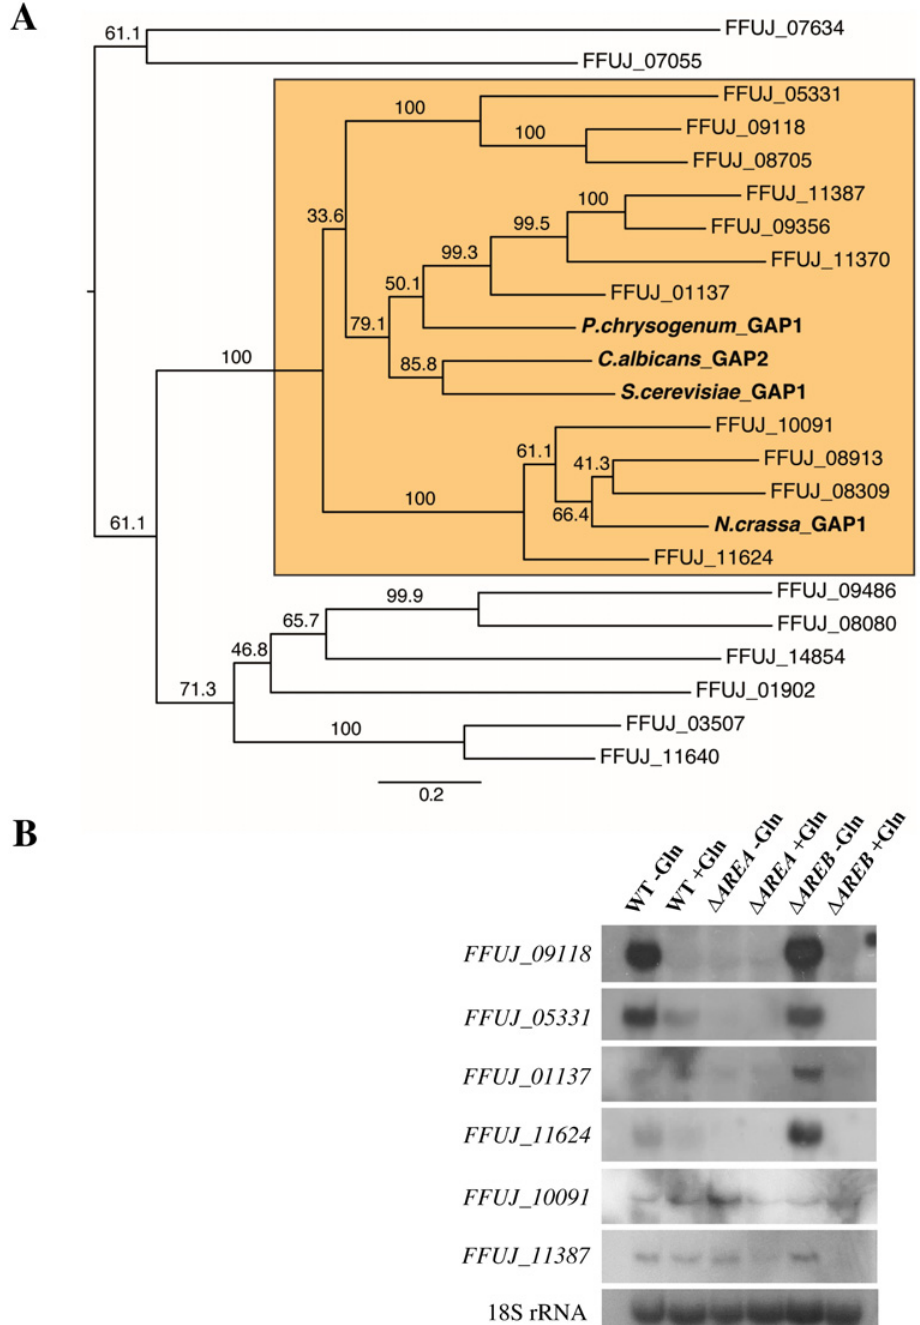
Fig 1. Identification of potential general amino acid permeases in F . fujikuroi . (A) Maximum likelihood tree showing the phylogenetical relationship between the general amino acid permeases (GAP) from S . cerevisiae [36], C . albicans [37], N . crassa [38], P . chrysogenum [39], and 19 F . fujikuroi proteins with the highest sequence homology to S . cerevisiae Gap1. Branches show bootstrap values (%), scale bar indicates amino acid substitutions per site. The fungal GAP proteins branched together with eleven putative GAP sequences of F . fujikuroi (orange box) (B) Expression analysis of putative GAP-encoding genes in F . fujikuroi . Total RNA was isolated from the wild-type and the Δ AREA and Δ AREB deletion mutants grown for 3 days in ICI liquid cultures with 6 mM (-Gln) or 60 mM (+Gln) glutamine as single nitrogen source and used for Northern blot analysis. 18S rRNA was visualized as loading